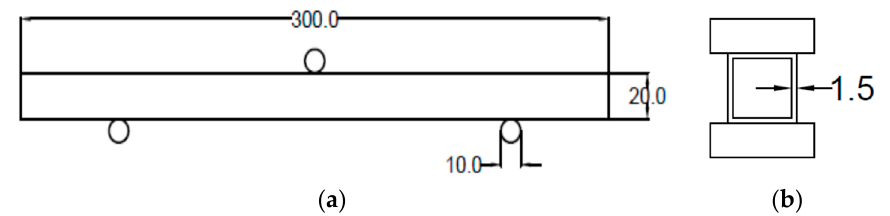
Figure 1. ( a ) Schematic diagram of flexural setup. ( b ) Cross section of AHT.